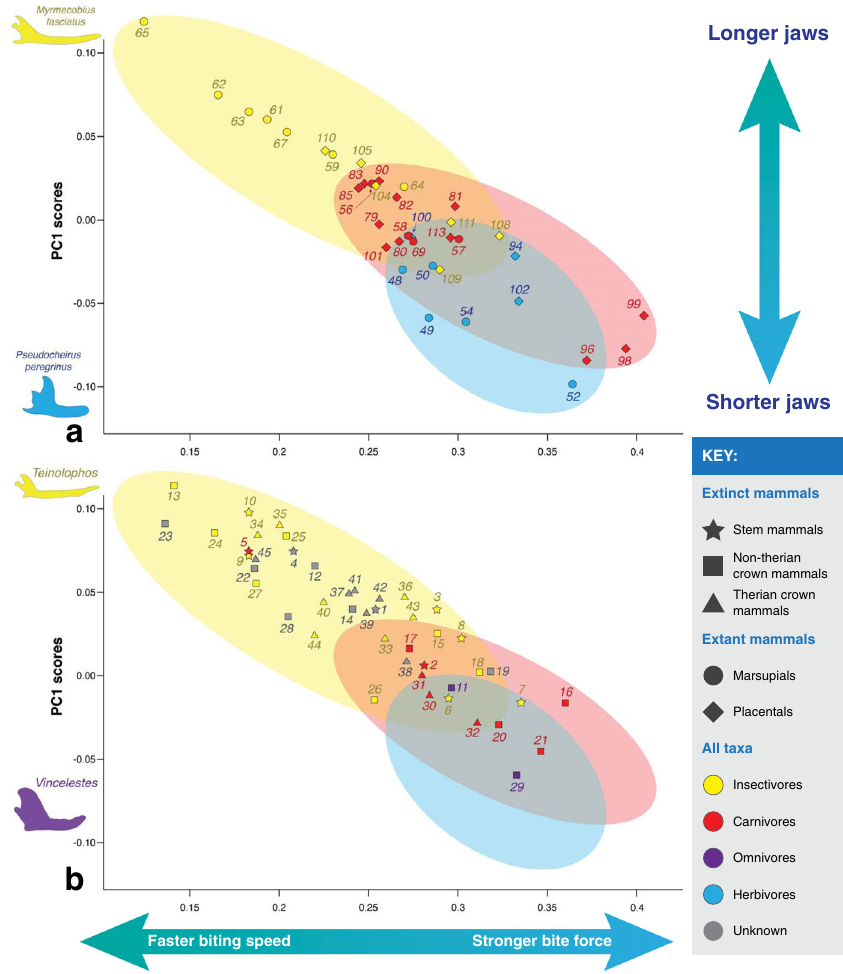
Fig. 7 Scatter plot of the mechanical advantage of the temporalis ( x axis) vs. PC1 scores from Fig. 3 ( y axis), which mainly describes jaw length. a Extant taxa, b extinct taxa. Colors indicate known dietary categories of extant mammals and suggested dietary categories for Mesozoic mammals (obtained from the literature). Ovals indicate where extant taxa of known dietary categories plot, as in part a